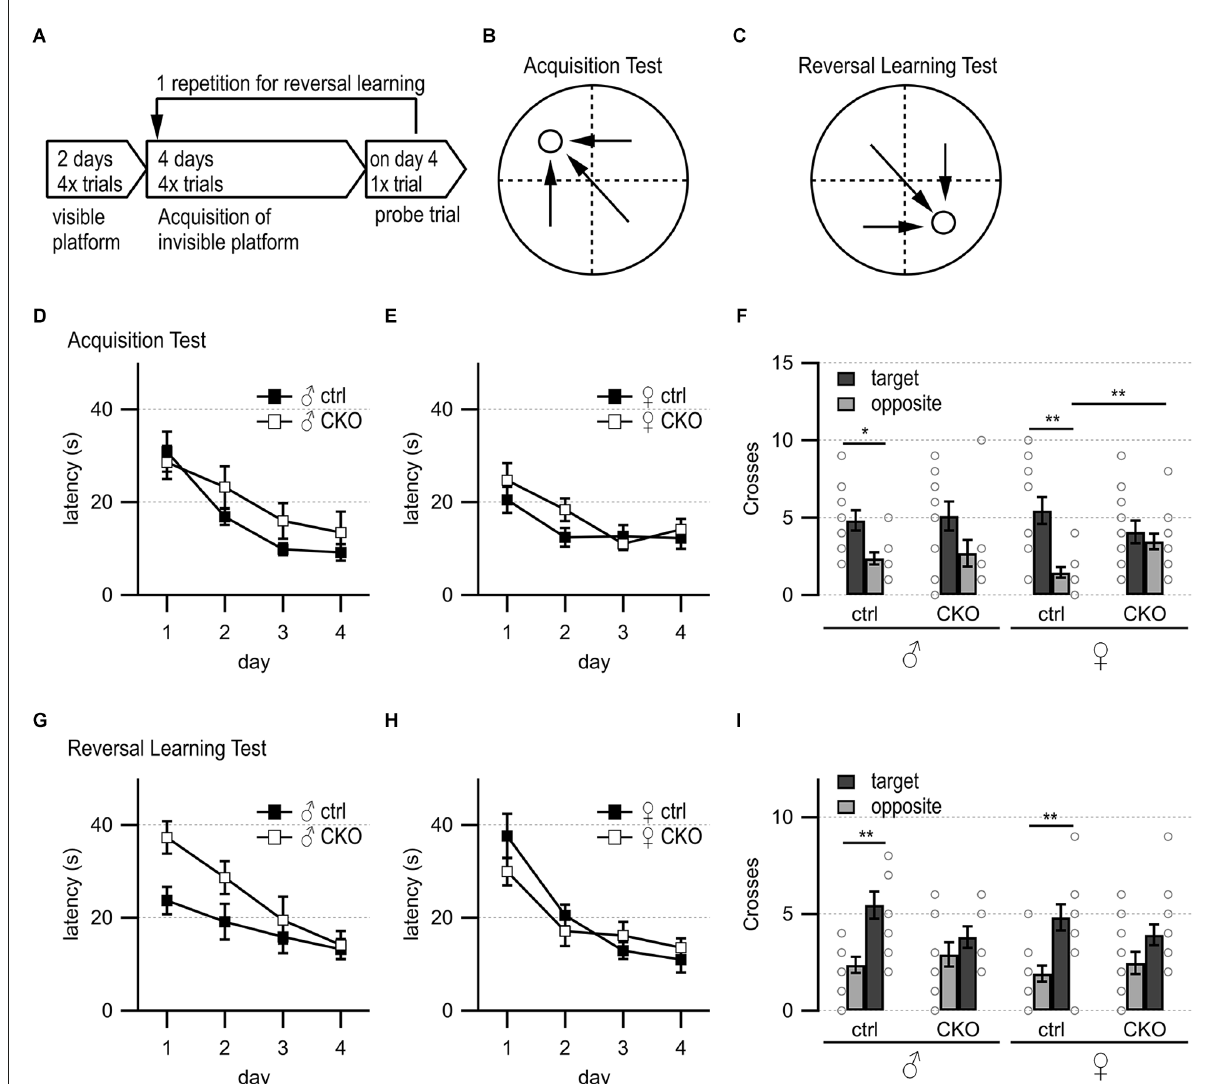
FIGURE2 Loss of GABA co-transmission from ACh neurons results in spatial memory deficits. Loss of GABA co-transmission leads to spatial memory impairments. (A) Timeline of Morris water maze experiment. Visible platform test, acquisition test using hidden platform followed by one probe trial without platform, reversal learning test with hidden platform in the opposite quadrant, and one probe trial without platform. (B) Water maze setup for acquisition test. Visible/hidden platform placed at the circle. Start points chosen in arbitrarily random order. Theoretical escape pathway to hidden platform indicated by arrows. (C) Water maze setup for reversal test with hidden platform placed in opposite quadrant. (D,E) Latency to reach the hidden platform during acquisition learning for males (D) and females (E) . (F) Probe trial results after acquisition learning phase in absence of the platform. Counts of target and opposite quadrant crosses. (G,H) Latency to reach the hidden platform during reversal learning for males (D) and females (E) . (I) Probe trial results after reversal learning phase in absence of the platform. Counts of swimming path crosses over the platform area in target quadrant and corresponding area in the opposite quadrant. Values represent mean ± SEM. Individual data points are depicted as open circles. Repeated measures ANOVA followed by Fisher’s protected least-significant difference (* p < 0.05, ** p < 0.01). See Supplementary Table 3 for